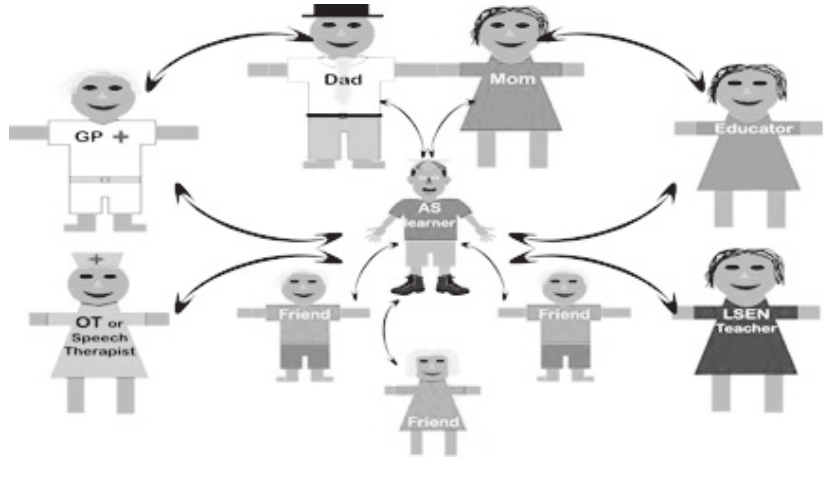
Figure 2: Effective learning and development in a complex set of relationships